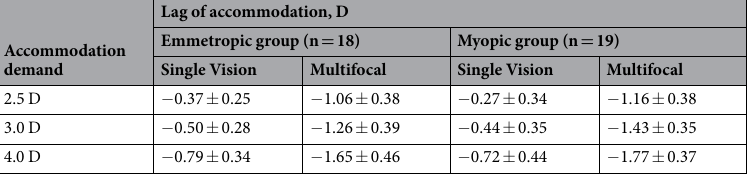
Table 2. Average values of lag of accommodation with different contact lens types. Mean and standard deviation of the lag of accommodation with Biofinity single vision vs. multifocal soft contact lenses at the three tested distances in both study groups.